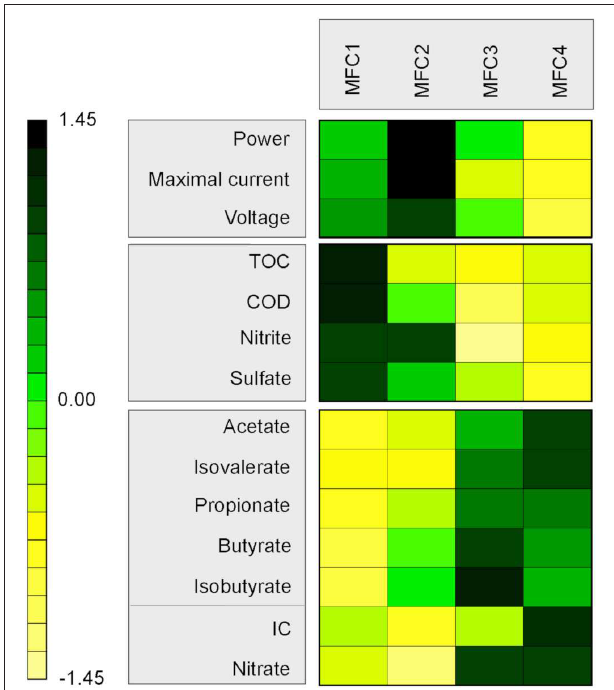
FIGURE 2 | Heatmap of chemical variables as a function of MFC stages. Variables were centered and scaled. The higher values are in green and the lower values in yellow. TOC and IC variables are respectively the total organic carbon and the inorganic carbon concentration. COD variable is the chemical oxygen demand